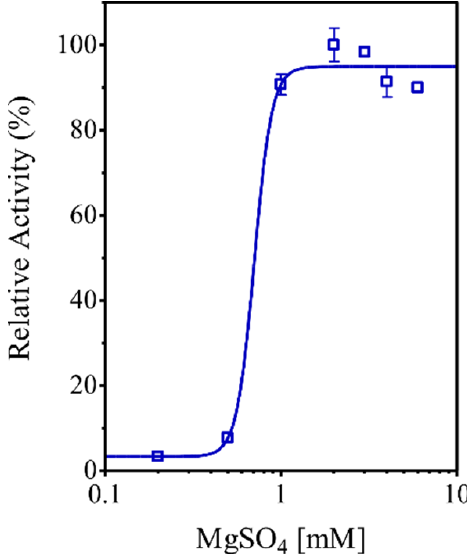
Figure 5. Effect of magnesium ions (Mg 2+ ) on the r Eh HAPp49 PPase activity. Bars represent the standard error (n = 3).